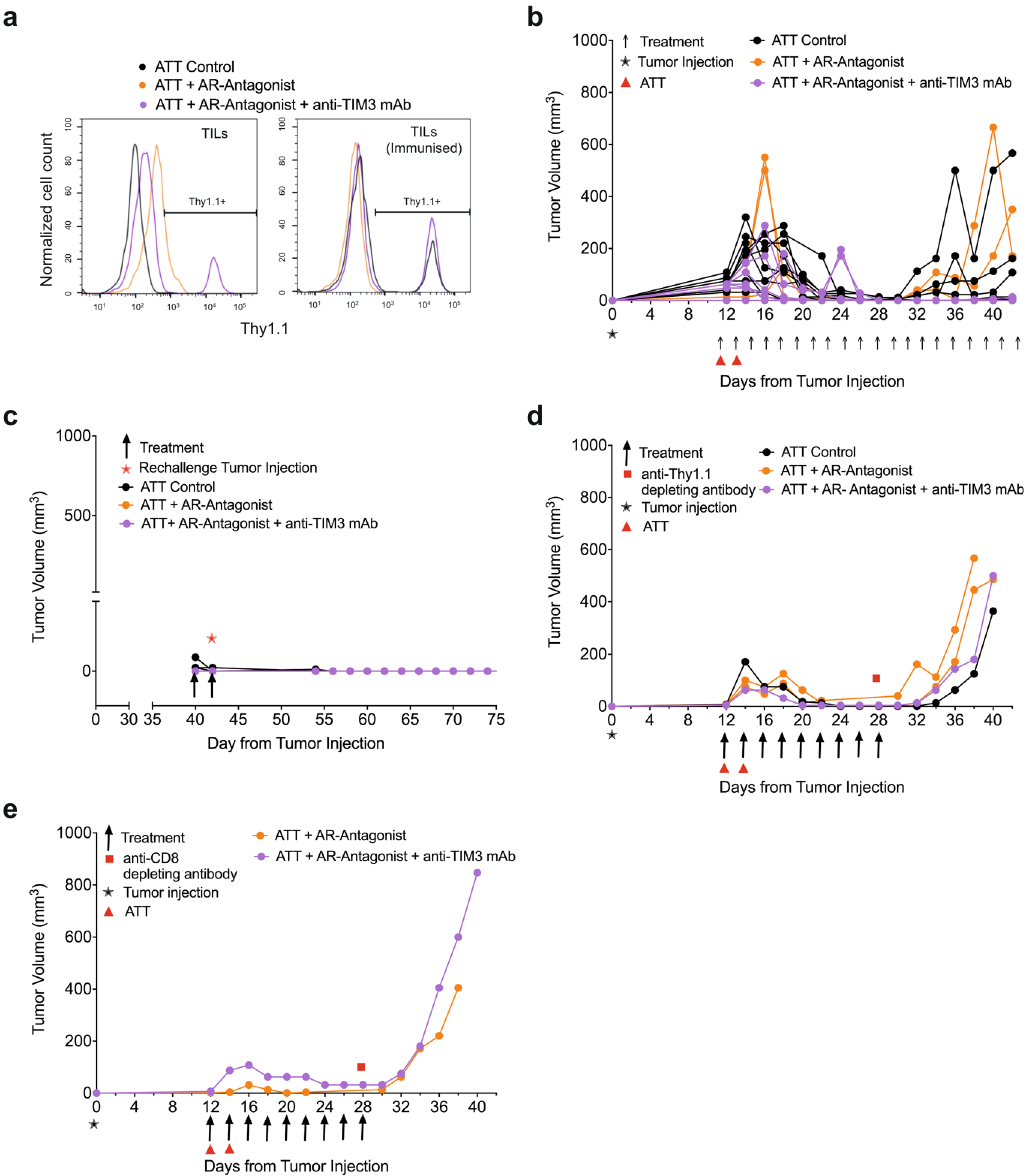
Fig. 4 A 2A R antagonist plus anti-TIM3 mAb diminish tumor relapse in a T cell-dependent fashion. Mouse numbers across the different parts of the experiments are detailed in Supplementary Fig. 2a. a RencaHA tumor-bearing BALB/c were injected i.v. with two doses of 5 × 10 6 Thy1.1 + CL4 CTL (ATT) plus either vehicle and isotype control, A 2A R-antagonist (ZM 241385) alone or A 2A R antagonist + anti-TIM3 mAb as shown. The percentage of Thy1.1 + CL4 TIL between days 25 and 48 is given as representative data from N = 25 mice over three independent experiments. Mice were either immunized with HA peptide 5 days prior to TIL harvest ( N = 5) to induce expansion of Thy1.1 + CL4 T cells or immunized with empty vehicle control ( N = 19); one representative graph is shown for each group. b – e Tumor growth curves from individual mice treated in Fig. 3a, which had experienced complete and durable tumor remission. b untreated and c rechallenged with tumor cells at day 40; d depleted of Thy1.1 + T cells using anti-Thy1.1 depleting mAb at 28 days; e depleted of all CD8 + T cells using anti-CD8 β depleting mAb at 28 days with depletion ef fi ciency shown in Supplementary Fig. 2b. Source data are provided in Supplementary Data As an additional process requiring cytoskeletal activity, we defective cytoskeletal polarization of TIL. Consistent with the examined the in fi ltration of endogenous CD8 + T cells and CL4 importance of such CTL cytoskeletal polarization for cytolysis, treatment of tumors with the A 2A R antagonist ZM 241385 plus CTL into Renca tumors in vivo. Such in fi ltration was focused on blocking anti-TIM3 mAb signi fi cantly ( p = 0.02) enhanced peripheral tumor regions and was enhanced upon treatment with ex vivo CL4 TIL killing (Fig. 5f, g). We have also seen the the A 2A R antagonist ZM 241385 plus blocking anti-TIM3 mAb (Fig. 5h, i). In contrast, CD4 + Treg in fi ltration was diminished restoration of CTL cytoskeletal polarization and killing upon (Fig. 5i). An enhanced ratio of CD8 + CTL to CD4 + Tregs in the treatment of RencaHA tumor-bearing mice with anti-PD-1 7 . It is now of interest whether or not A 2A R and TIM3, in contrast to tumor thus constitutes an additional potential mechanistic PD-1 7 , directly regulate the interaction between CTL and their contribution of reduced tumor growth in mice upon blockade tumor target cells. of the A 2A R and TIM3.